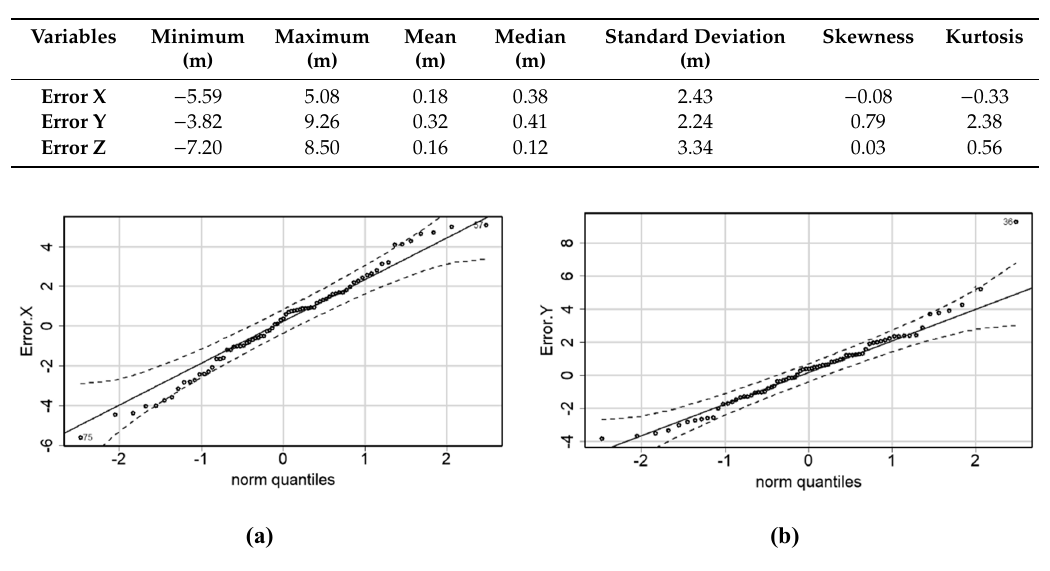
Figure 11. QQ-plots corresponding to variables calculated with the 75 GCP dataset: ( a ) error X; ( b ) error Y.